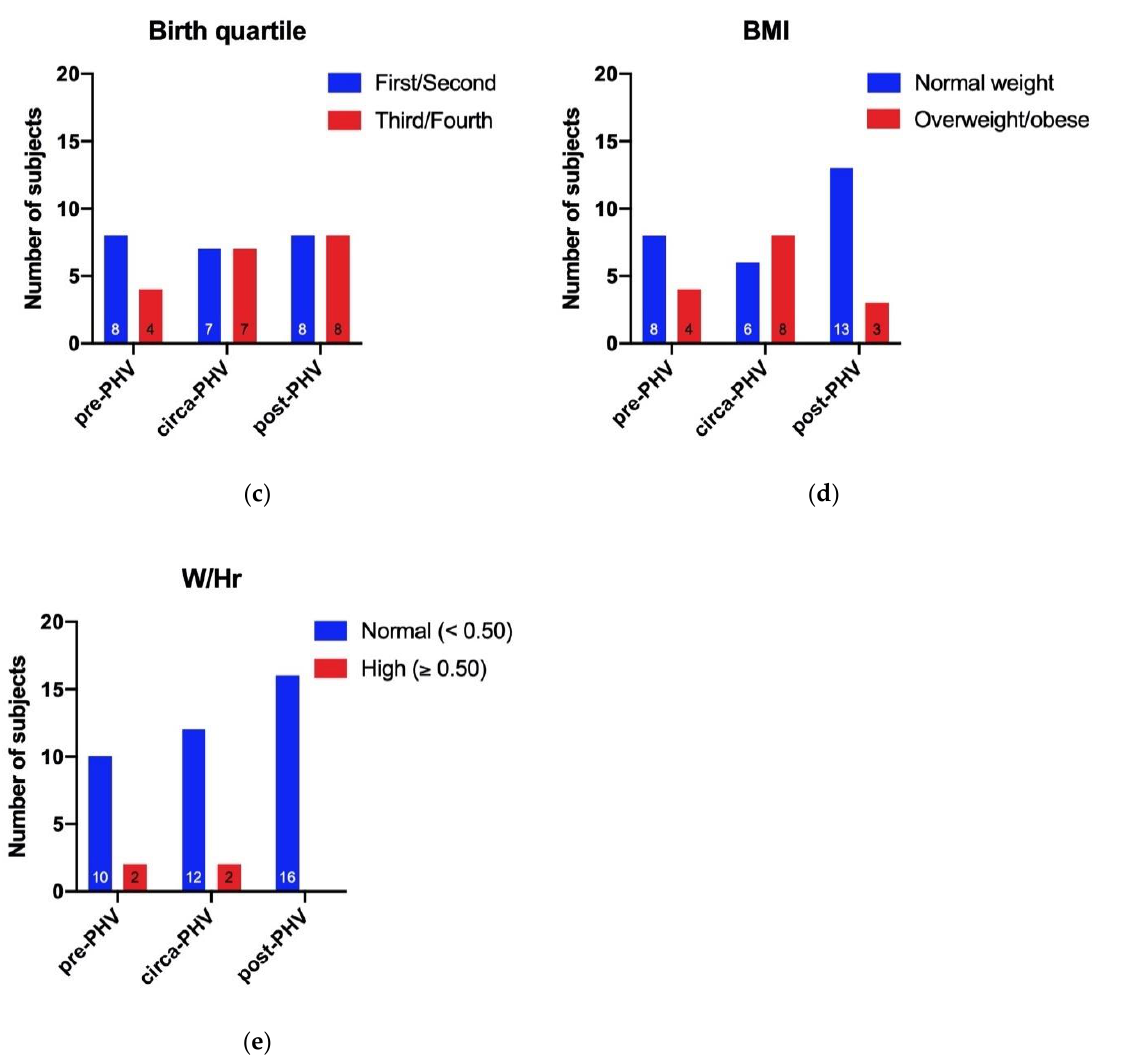
Figure 1. This figure summarizes the association of the three groups of goalkeepers with ( a ) WC, ( b ) achievement of peak growth, ( c ) birth quartile, ( d ) BMI, and ( e ) W/Hr. BMI = body mass index; WC = waist circumference; W/Hr = waist to height ratio.